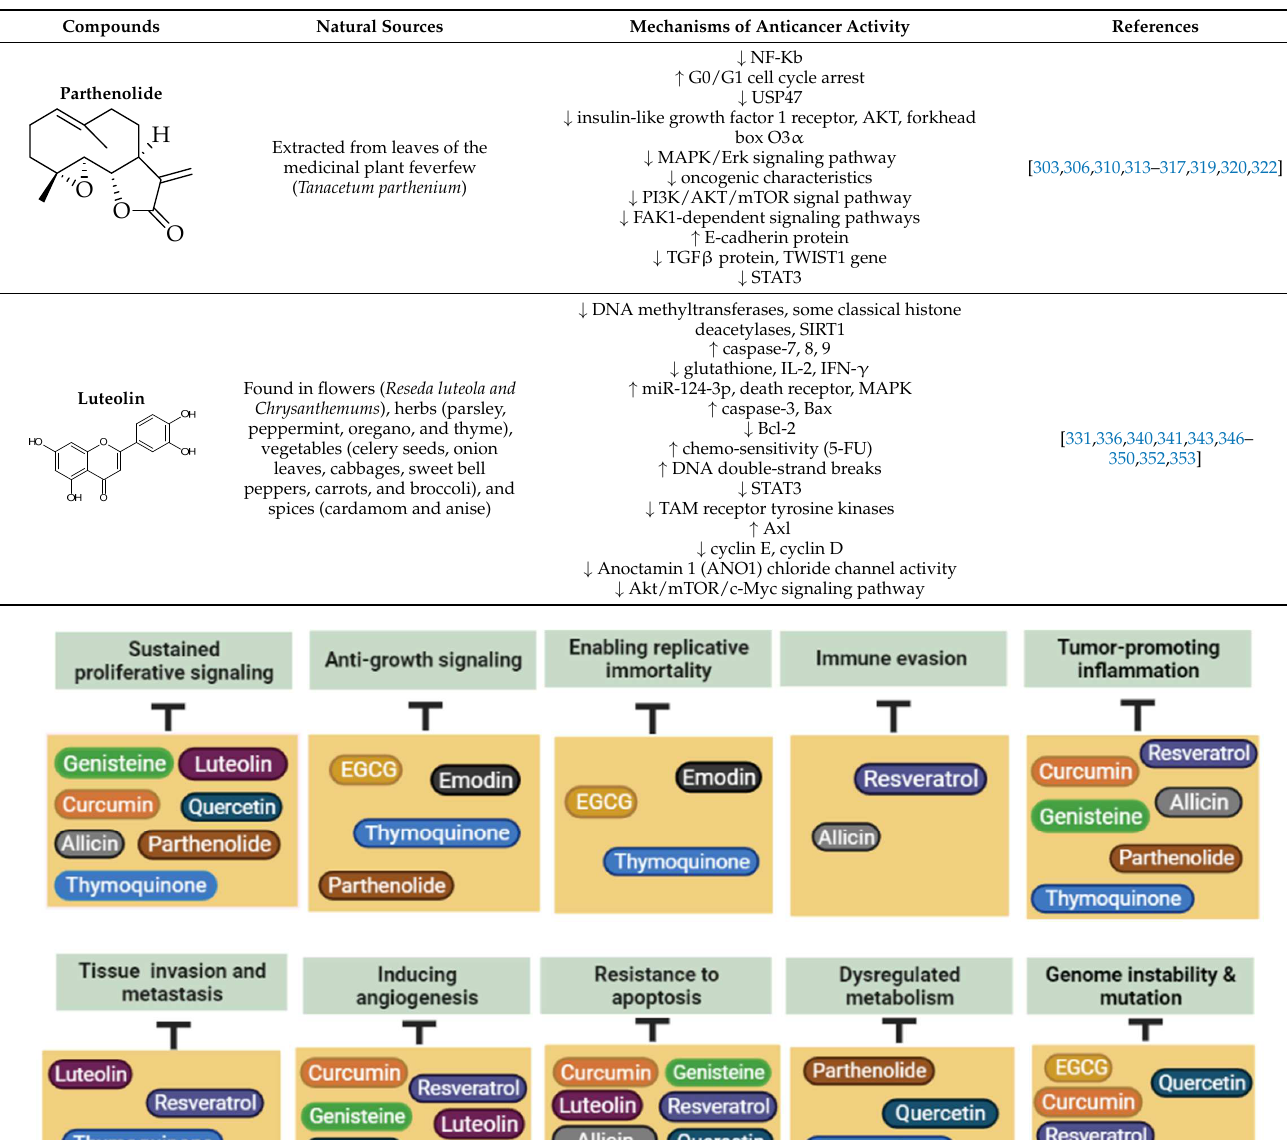
Figure 2. The effects of natural products on cancer hallmarks.